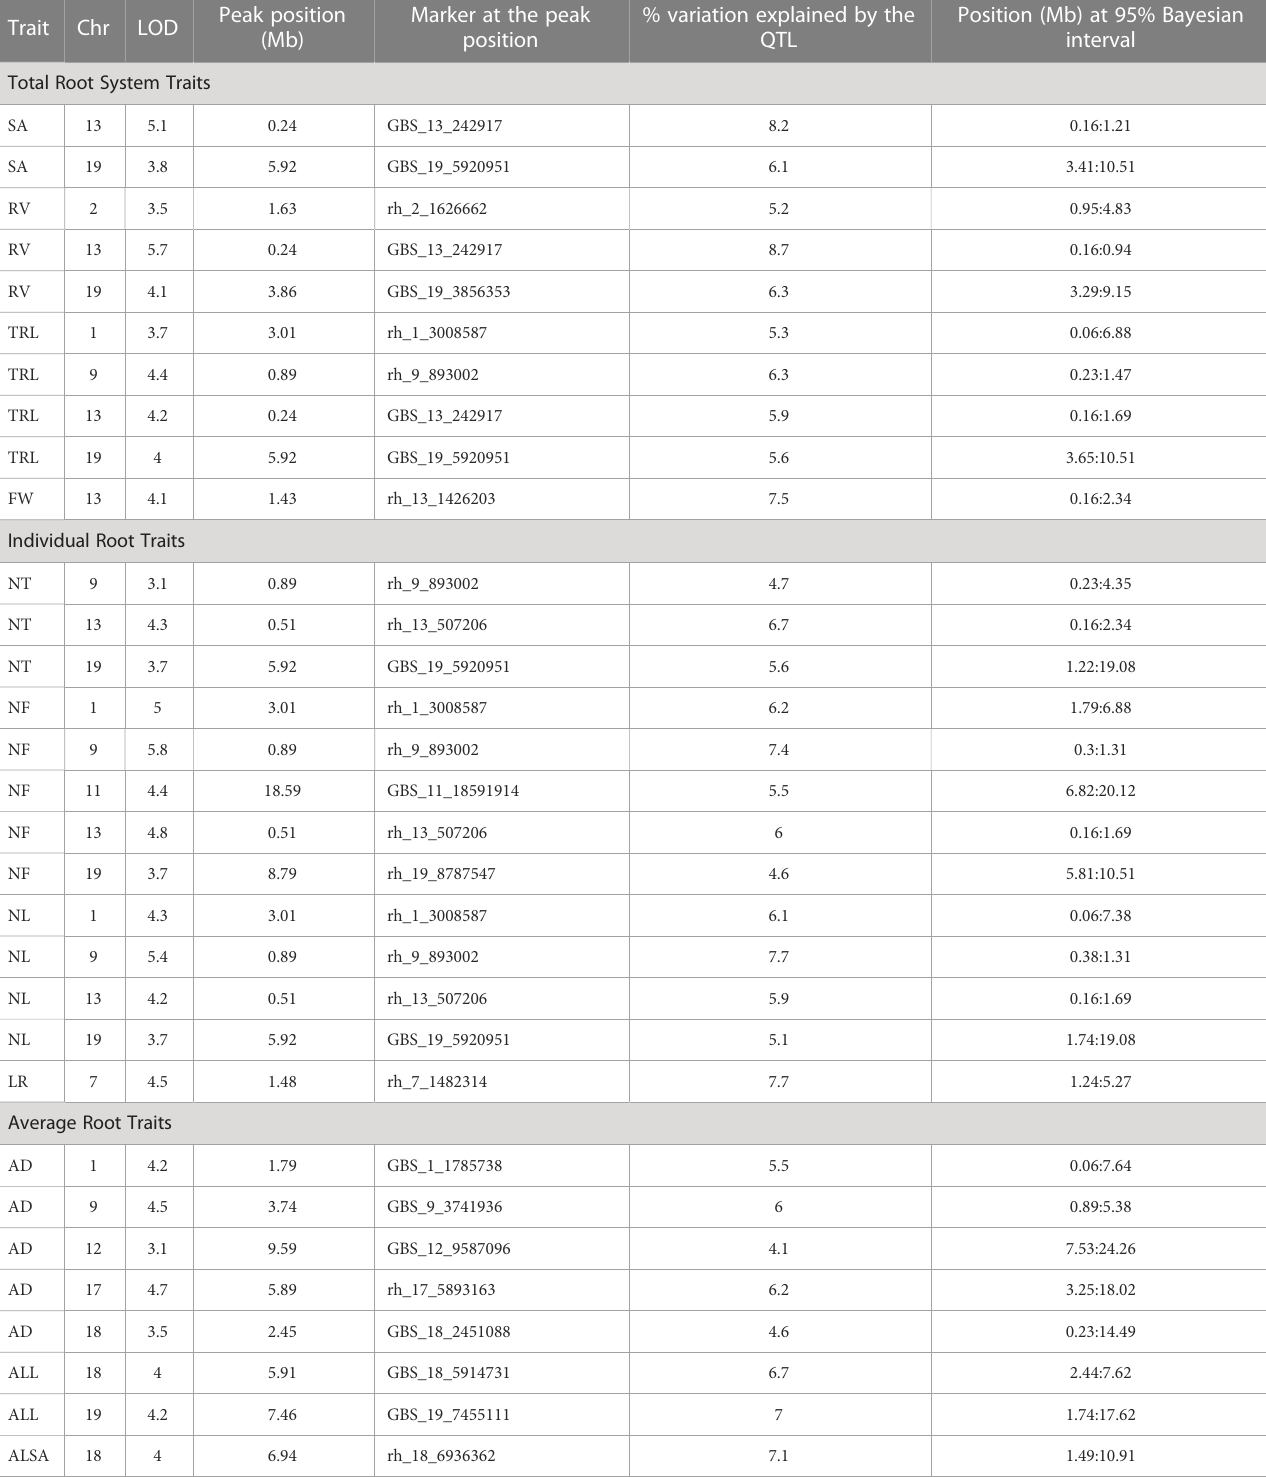
TABLE 4 Summarized QTL information for each